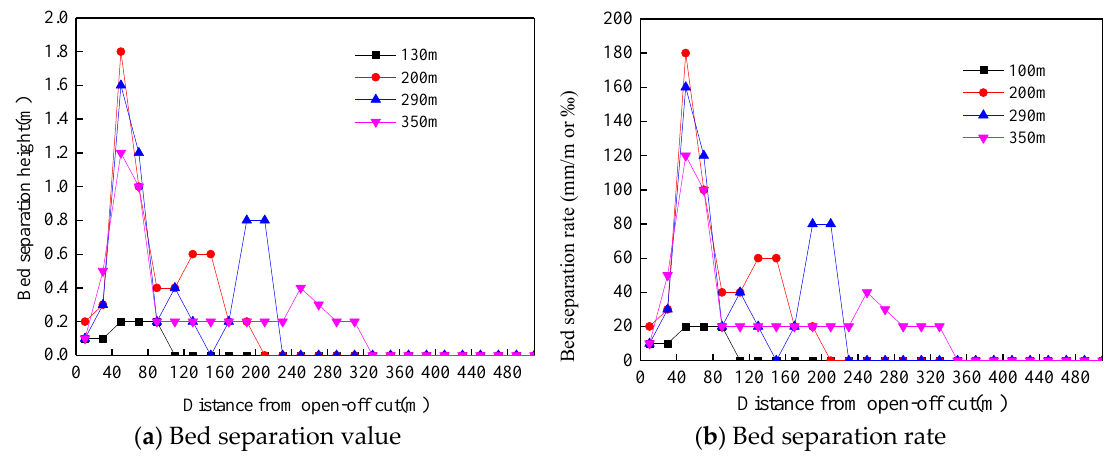
Figure 6. Dynamic evolution of the bed separation between the monitoring lines #2 and #3.